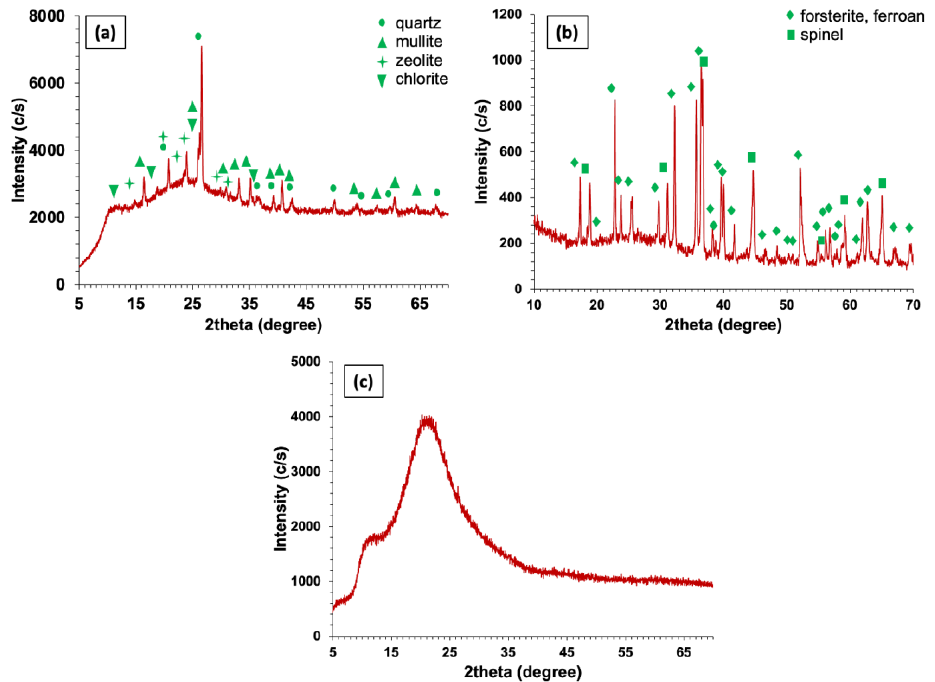
Figure 5. XRD patterns of ( a ) FA, ( b ) FS, and ( c ) SF.